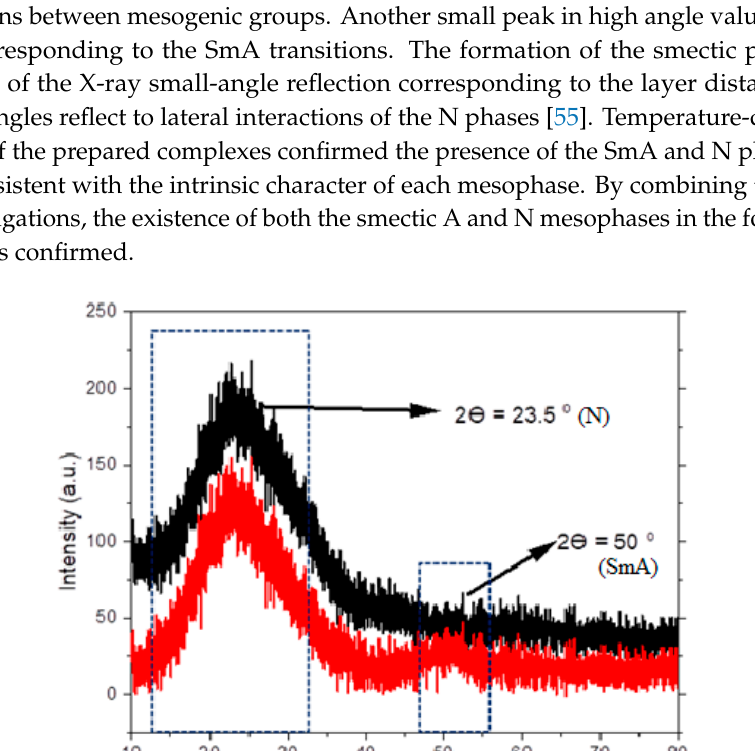
Figure 8. UV absorption spectrum of 1:2 SMHBCs, A/2Bn , in chloroform.